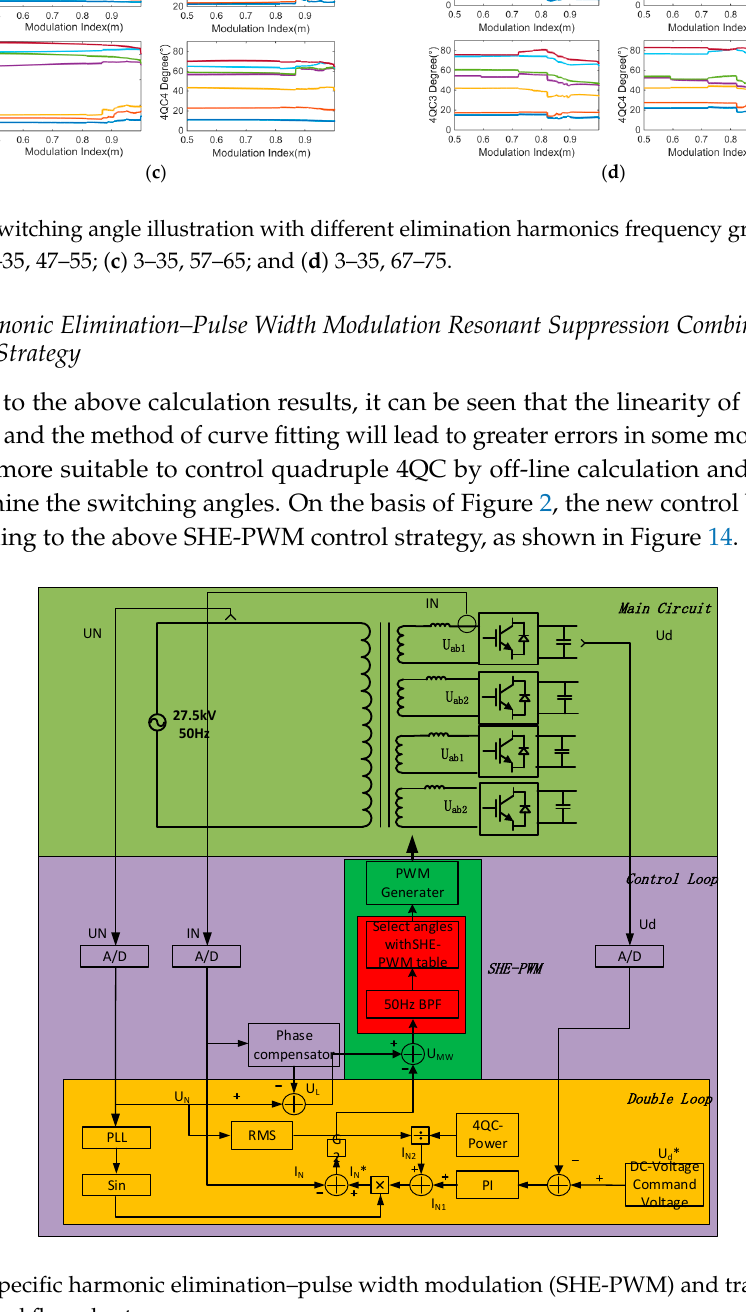
Figure 14. Specific harmonic elimination–pulse width modulation (SHE-PWM) and transient direct current control flow